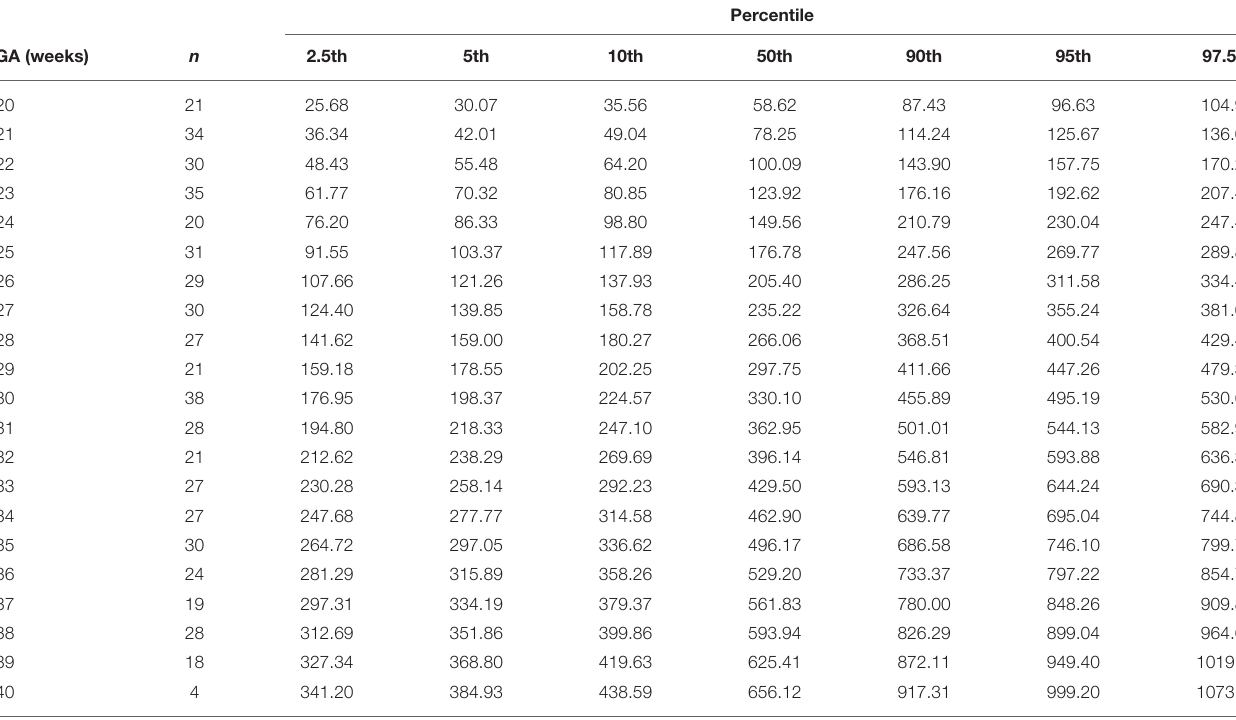
TABLE 7 | Percentiles of left ventricular cardiac output (ml/min) at 20–40 weeks of gestational age (GA).